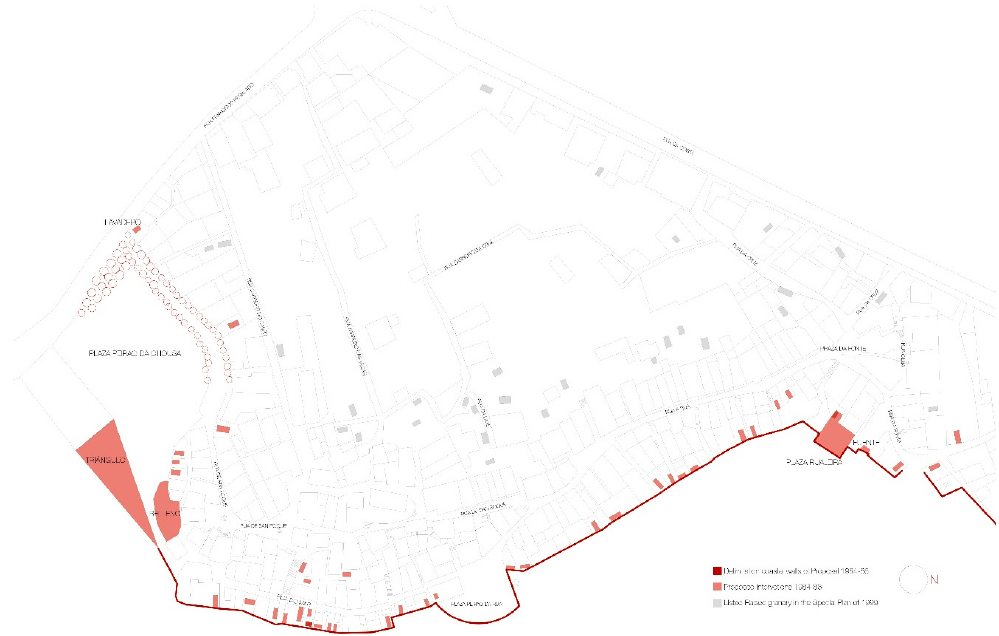
Figure 3. General plan of the Combarro Urban Intervention Proposal (Authorship: AFC).